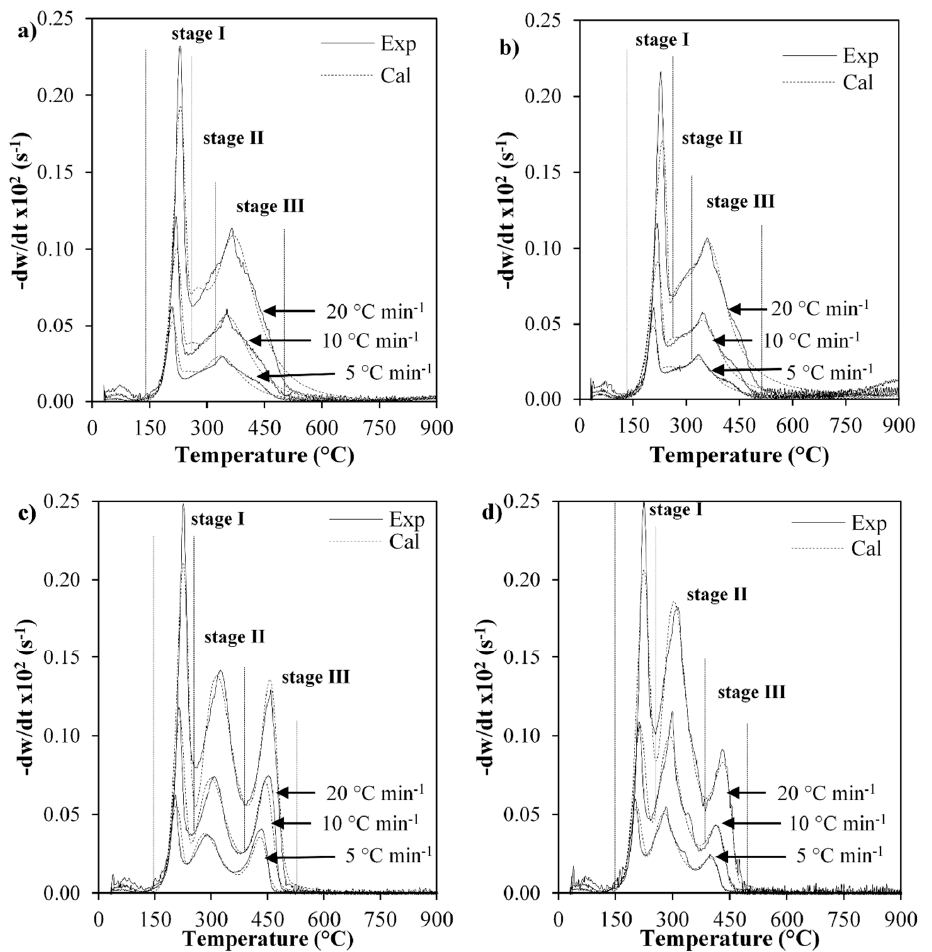
Figure 2. DTG curves during ( a , b ) pyrolysis (N 2 ) and ( c , d ) combustion (synthetic air) of ( a , c ) biomass and ( b , d ) biomass / catalyst 1:1. Catalyst: Rh-Pt / CeO 2 -SiO 2 . Continuous lines for experimental data (Exp) and dashed lines for calculated data (Cal).